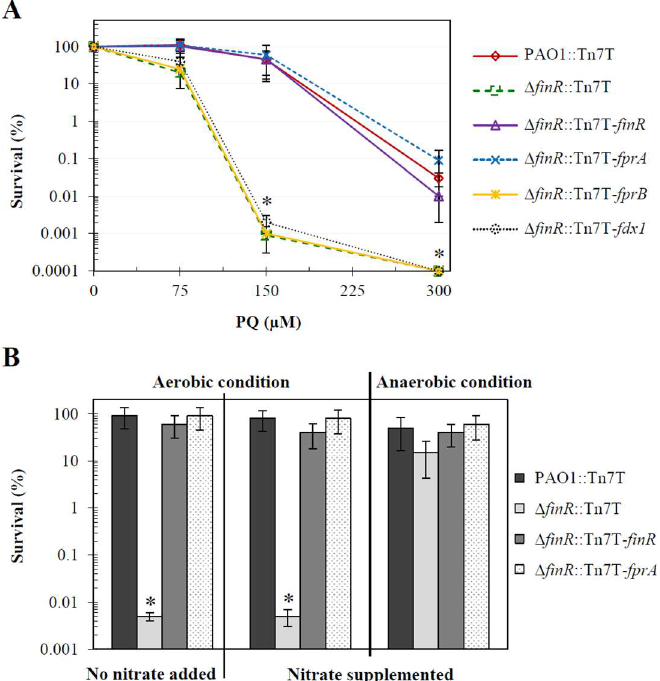
Fig 5. Determination of paraquat resistance levels in P . aeruginosa strains. (A) Paraquatresistance levels in PAO1 containing the mnin-Tn7vector control (PAO1::Tn7T, red) and Δ finR mutants containing Tn7T (dotted green), Tn7T- finR (purple),Tn7T- fprA (dotted blue), Tn7T- fprB (yellow),or Tn7T- fdx1 (dotted black) were determinedusing plate sensitivity assays. (B) Paraquat(150 μ M) resistancelevels of P . aeruginosa strains were determined using LB with and without 1% (w/v) KNO 3 supplementation and incubatedunder aerobic and anaerobicatmospheres. The survival is expressedas a percentage of the CFU on LB plates containing paraquatover the CFU on plates without paraquat. Data shown are means ± SD from three independent